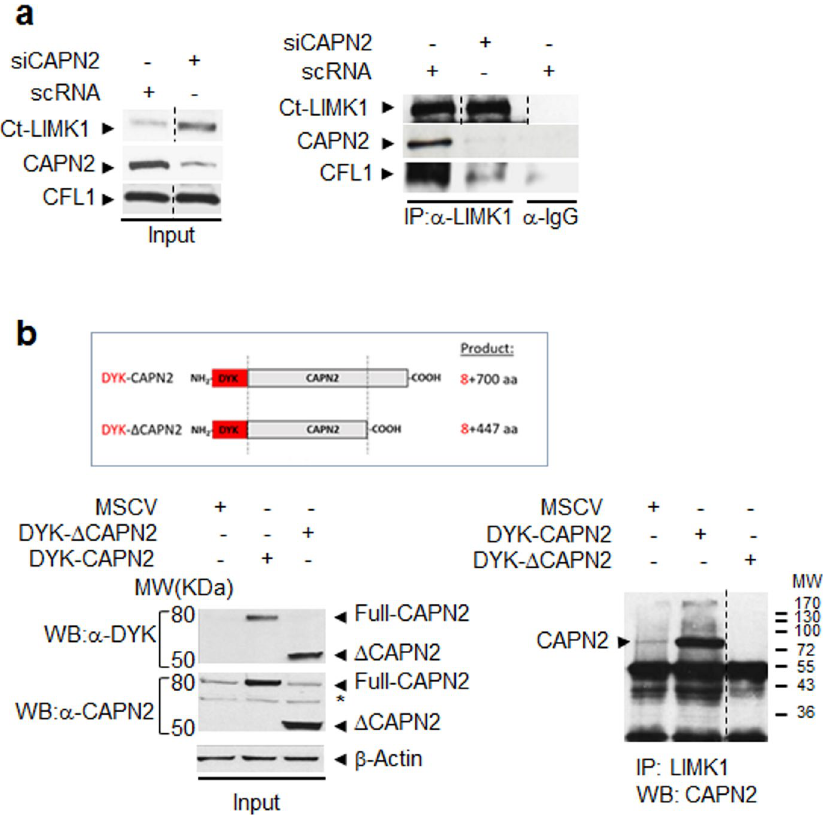
Figure 6. Direct interaction of CAPN2 and LIMK1 in MDA-MB-231 cells. ( a ) Coimmunoprecipitation of LIMK1 and CAPN2 in protein extracts from MDA-MB-231 cells transfected with scRNA/siCAPN2. Whole extracts were immunoprecipitated with anti-Ct-LIMK1 and analyzed by western blot with anti-CAPN2 and anti-CFL1 antibodies. Inputs are shown. ( b ) Full-length DYK-CAPN2 or DYK-∆CAPN2 was overexpressed in MCF-7 cells (graphical representation is shown). Protein extracts were immunoprecipitated with anti-Ct- LIMK1 and analyzed by western blot with anti-CAPN2 antibody. Uncropped image is shown. Inputs were analyzed with DYK, CAPN2 or β-actin antibodies (left panel). (*) Unspecific bands recognized by CAPN2 antibody. Juxtaposed images from different lanes in the same blot are separated by dotted lines. Full-length blots are presented in Supplementary Fig.